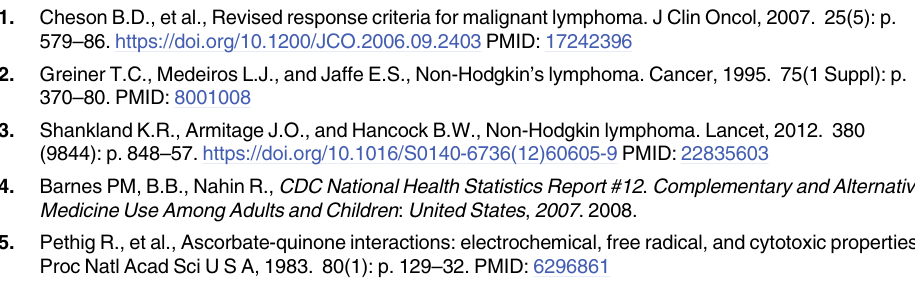
S7 Fig. Immune phenotypic profiling. Splenocytes from BALB/c mice treated with FWGP (140 μg/ml) or PBS (control) for 3 days were stained for flow cytometry. Immune populations were defined as follows: B cells, CD45+CD11b-CD19+; T cells, CD45+CD11b-CD3+; Myeloid cells, CD45+CD11b+; Tc, CD45+CD11b-CD3+CD4-CD8+; Th, CD45+CD11b-CD3+CD4 +CD8-; NK cells, CD45+CD11b-CD19-CD3-CD49b+; NKT cells, CD45+CD11b-CD3 +CD49b+. Data were gated for single cells and live cells before gating for lineage markers. Bars represent mean±SD. S1 Table. Cell survival and apoptosis panel. Quantitative PCR data from control and treated Raji cells at the indicated time points. Data were analyzed with Bio-Rad’s PrimePCR software.